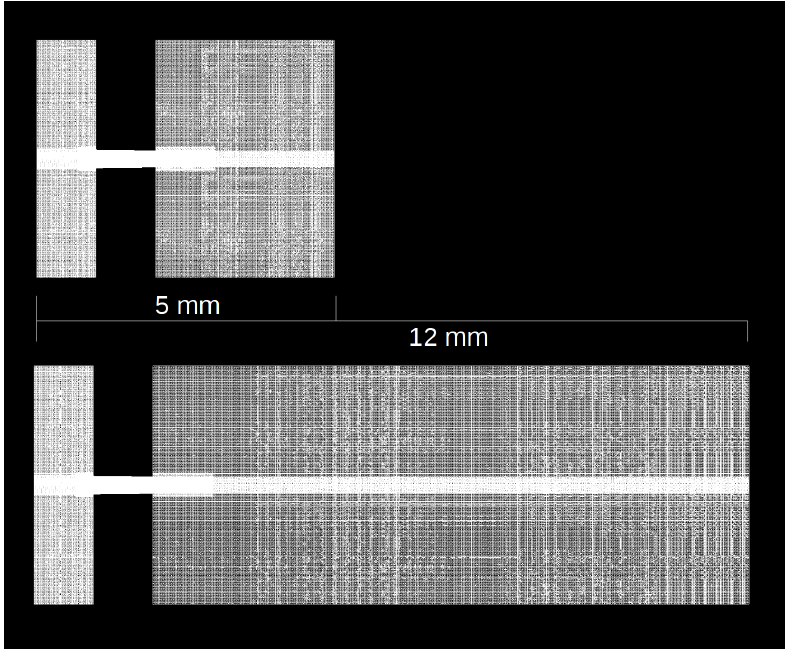
Figure 4. View of numerical grid for exit chamber lengths of 5 mm and 12